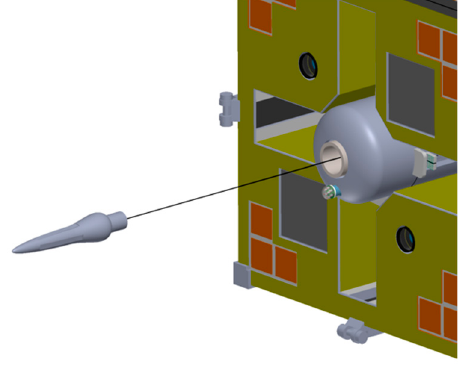
Figure 7. The harpoon launched from the launcher. (3) Robotic Arm Payload